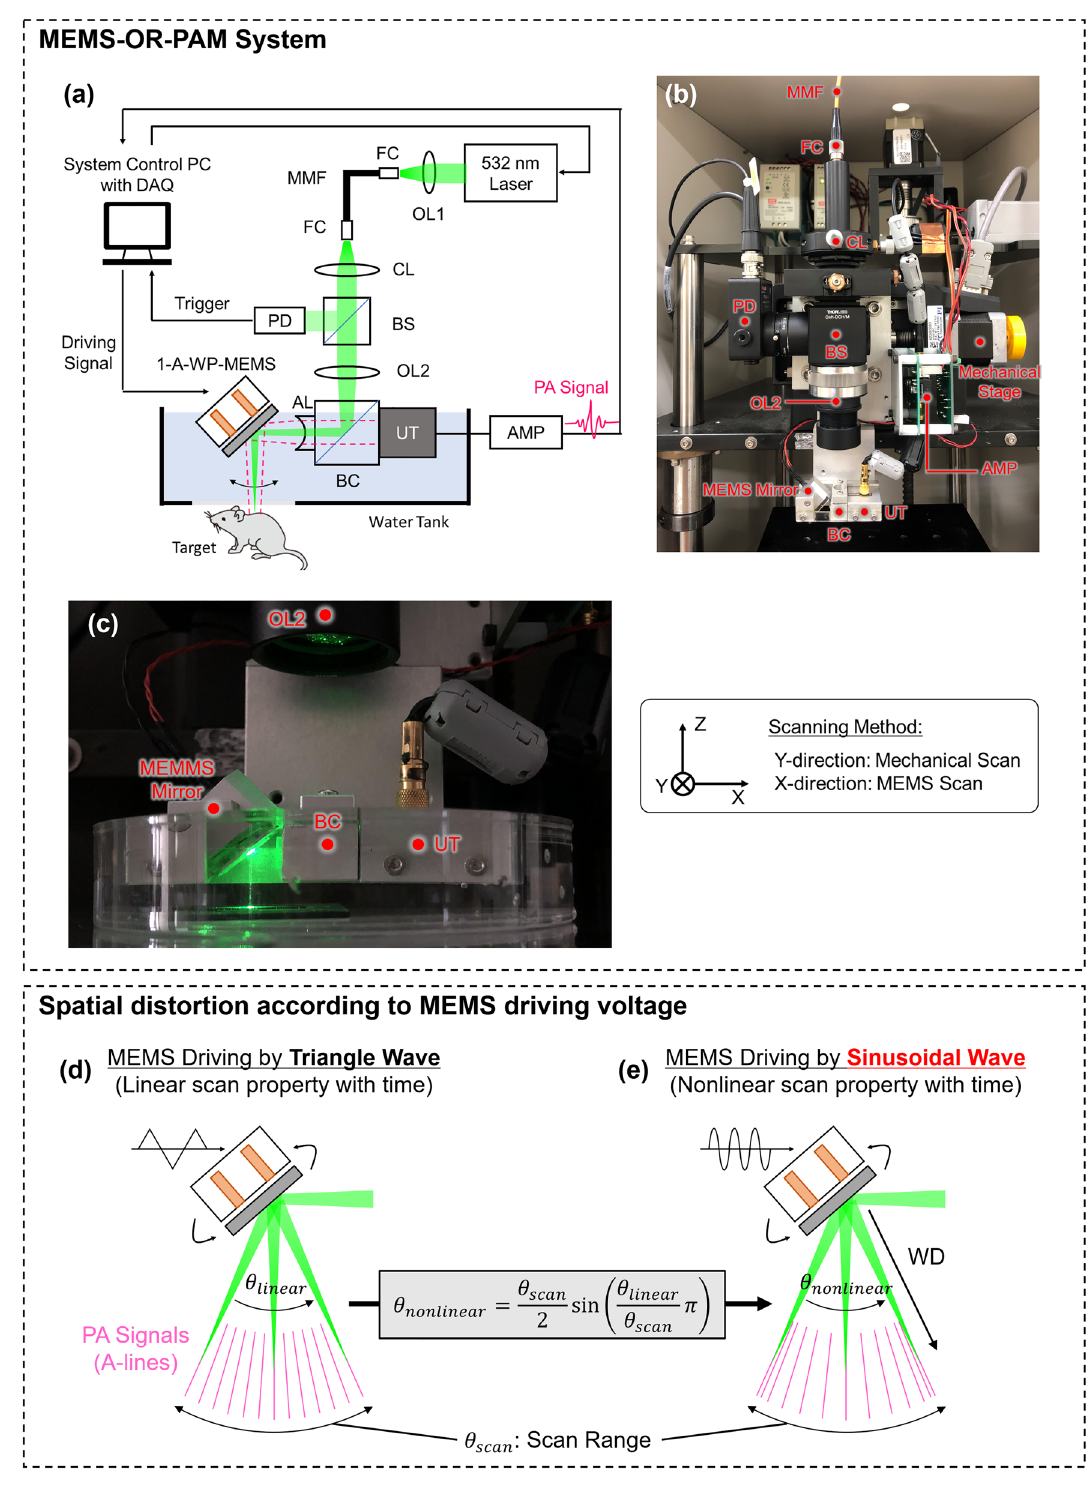
Figure 2. Schematic of experimental setup (upper dotted square) and spatial distortion according to MEMS driving voltage (lower dotted square). ( a ) Block diagram of developed MEMS-OR-PAM system. ( b ) Photo image. ( c ) Close-up view of the scanning part. ( d ) MEMS driving by triangle wave (linear with laser PRF timing). ( e ) MEMS driving by sinusoidal wave (nonlinear with laser PRF